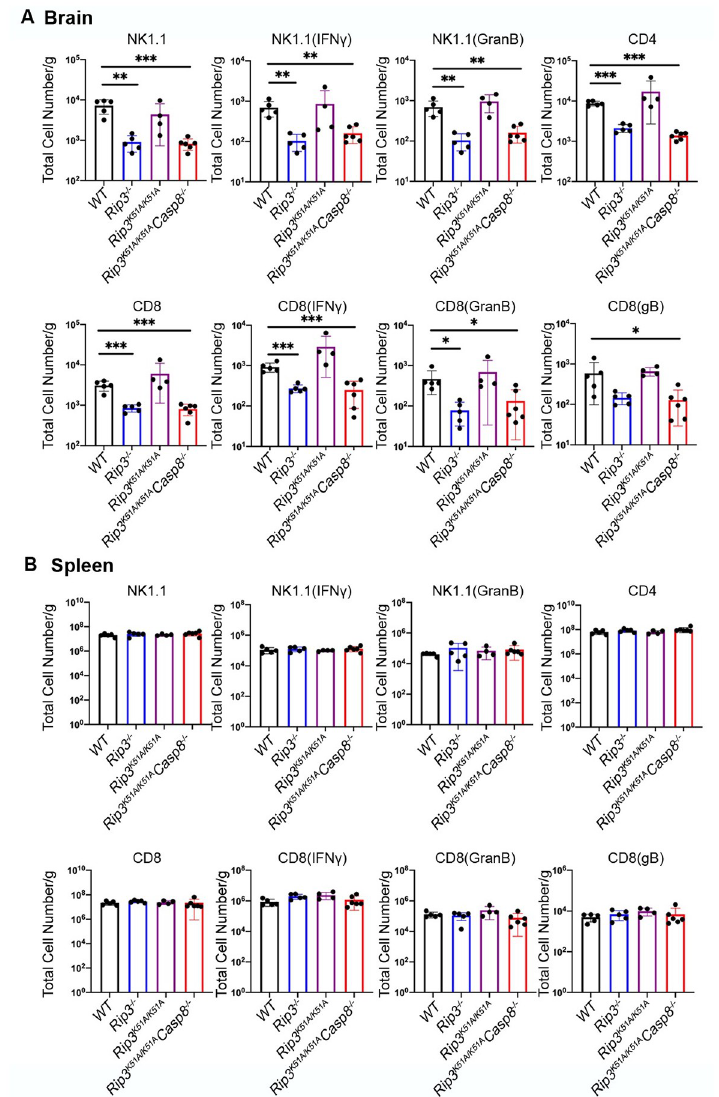
Fig 5. RIPK3 collaborates with Casp8 on NK and T cells recruiting to CNS during HSV1 infection. Numbers of NK, CD4 and CD8 T cells of total brain leukocytes (A) or spleen (B) from WT, Ripk3 -/- , Ripk3 K51A/K51A and Ripk3 K51A/K51A Casp8 -/- mice. Total IFN γ + and granzyme B + NK or T cell numbers by intracellular cytokine staining were also evaluated (n = 5–7 per group). All data are presented as mean ± SEM. � P < 0.05; �� P < 0.01; ��� P <